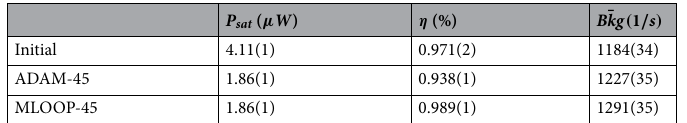
Table 1. Saturation power ( P sat ), detection efficiency ( η ) and average background count rate ( Bkg ) before and after optimization with different methods. P sat and η values are calculated by fitting the theoretical formula for Fluorescence Rate versus Laser Power to the experimental data 29–31 . A clear drop in saturation power is observed after ADAM and MLOOP optimization of individual electrodes indicating a reduction of the micromotion.